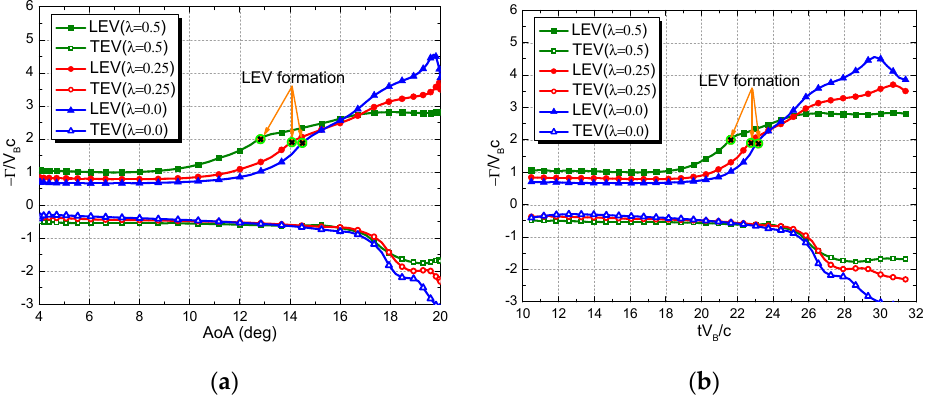
Figure 16. Comparisons of vortex circulation between different oscillating velocities (case 1). ( a ) Variation with AoA. ( b ) Variation with time.